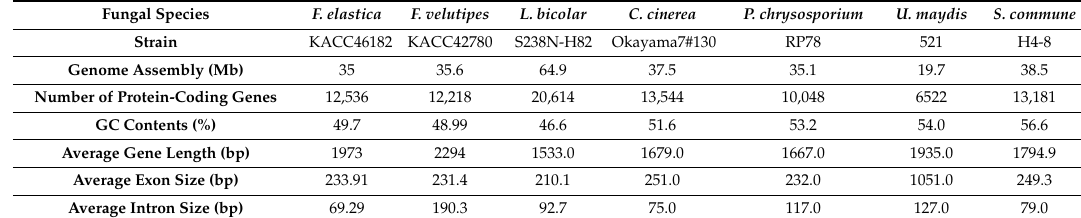
Table 2. Comparison of the Genome Characteristics of Flammulina elastica and other